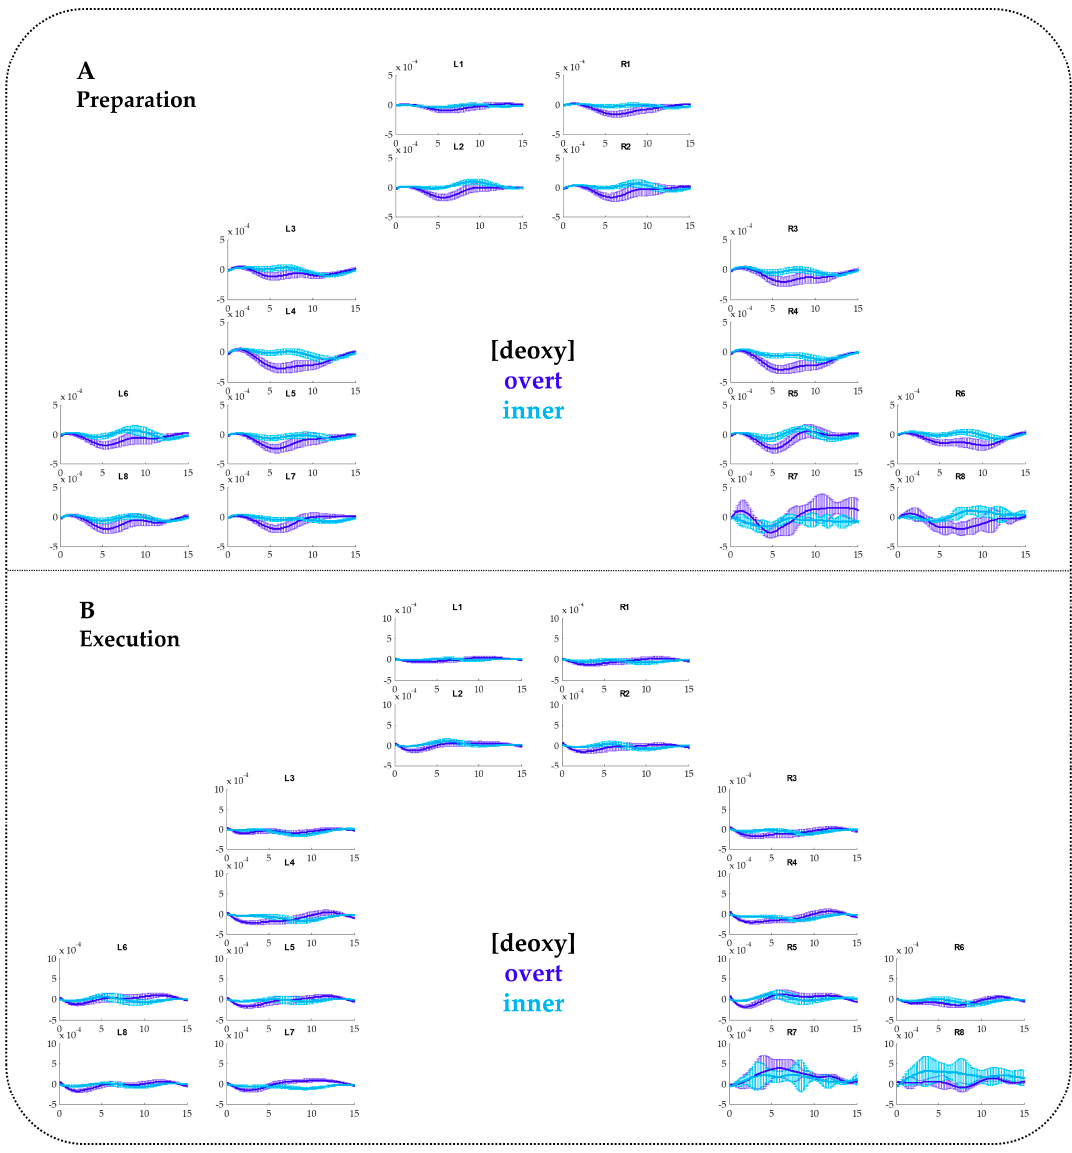
Figure A3. FNIRS time courses for [deoxy-Hb] including standard errors of the mean (SEMs) contrasting overt and inner speech for the Preparation phase ( A ) and the Execution phase ( B